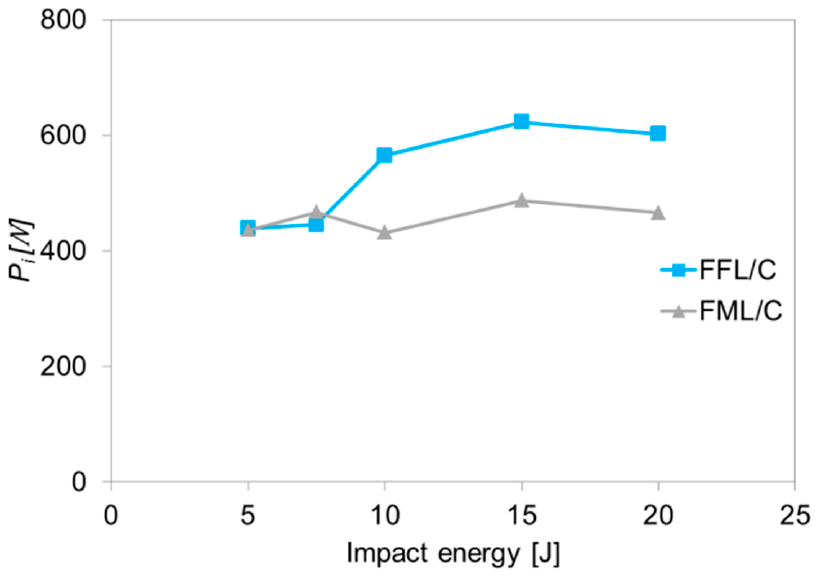
Figure 3. P i of laminates depending on impact energy.